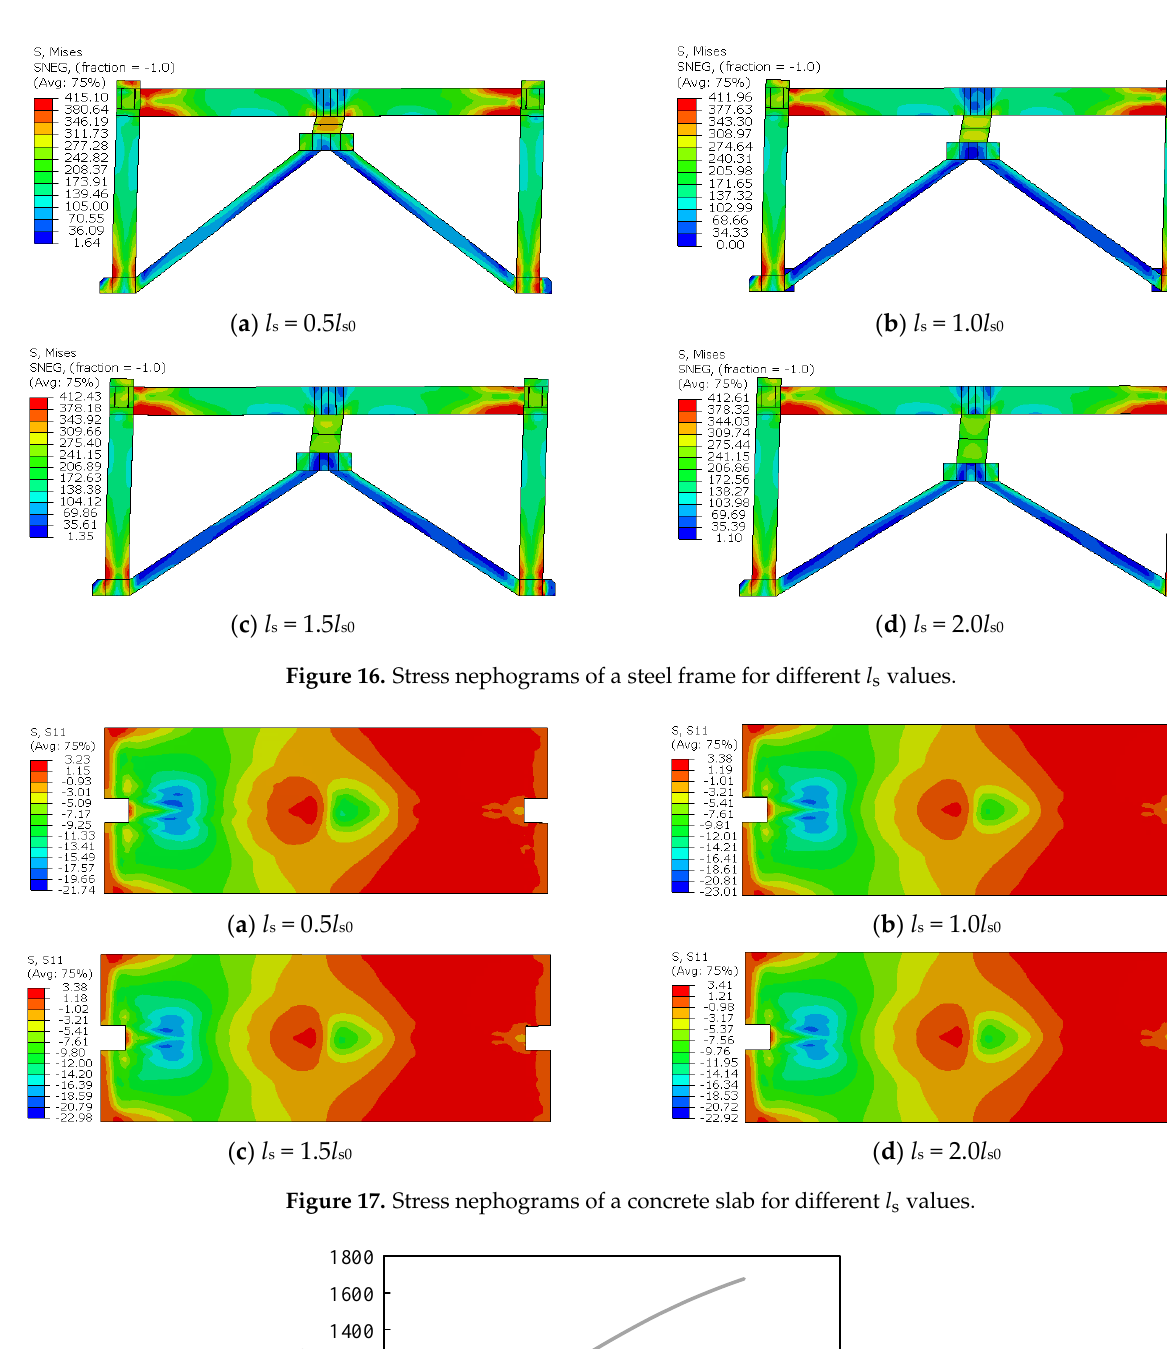
15 of 24 Table 4. Comparison of mechanical properties for different α values. Beam-to-Column Linear Stiffness Ratio